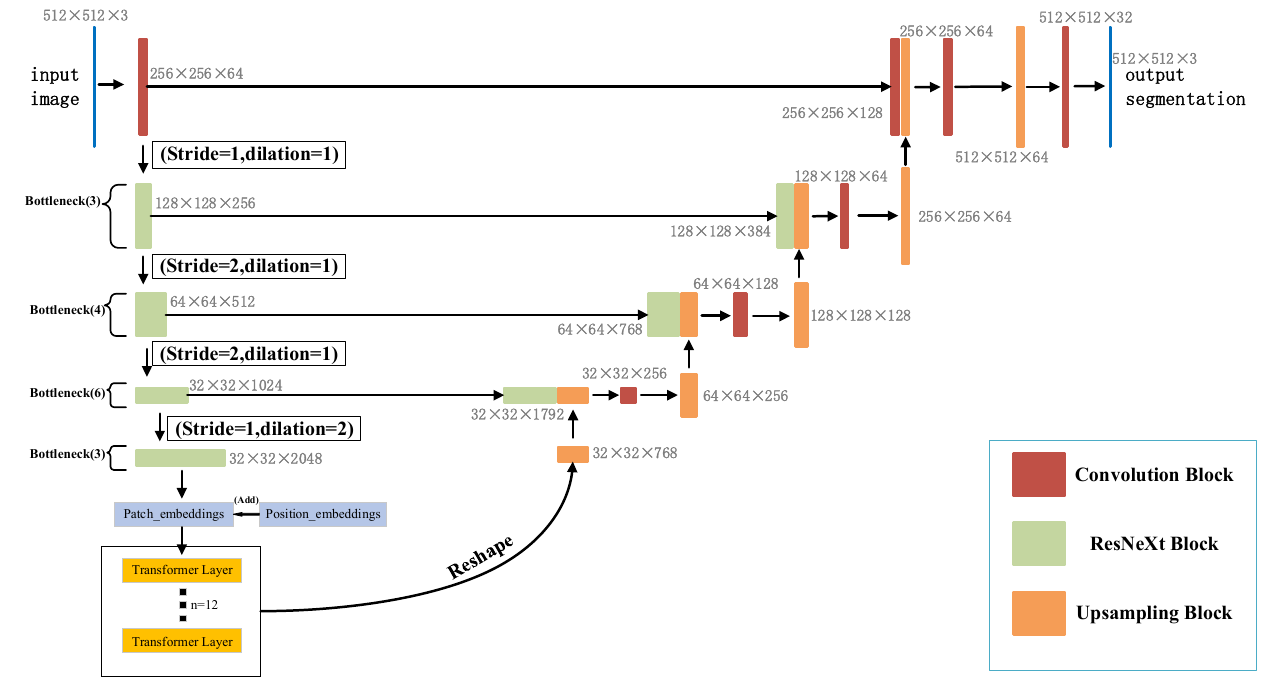
Figure 2. Network structure diagram of RDCTrans U-Net.